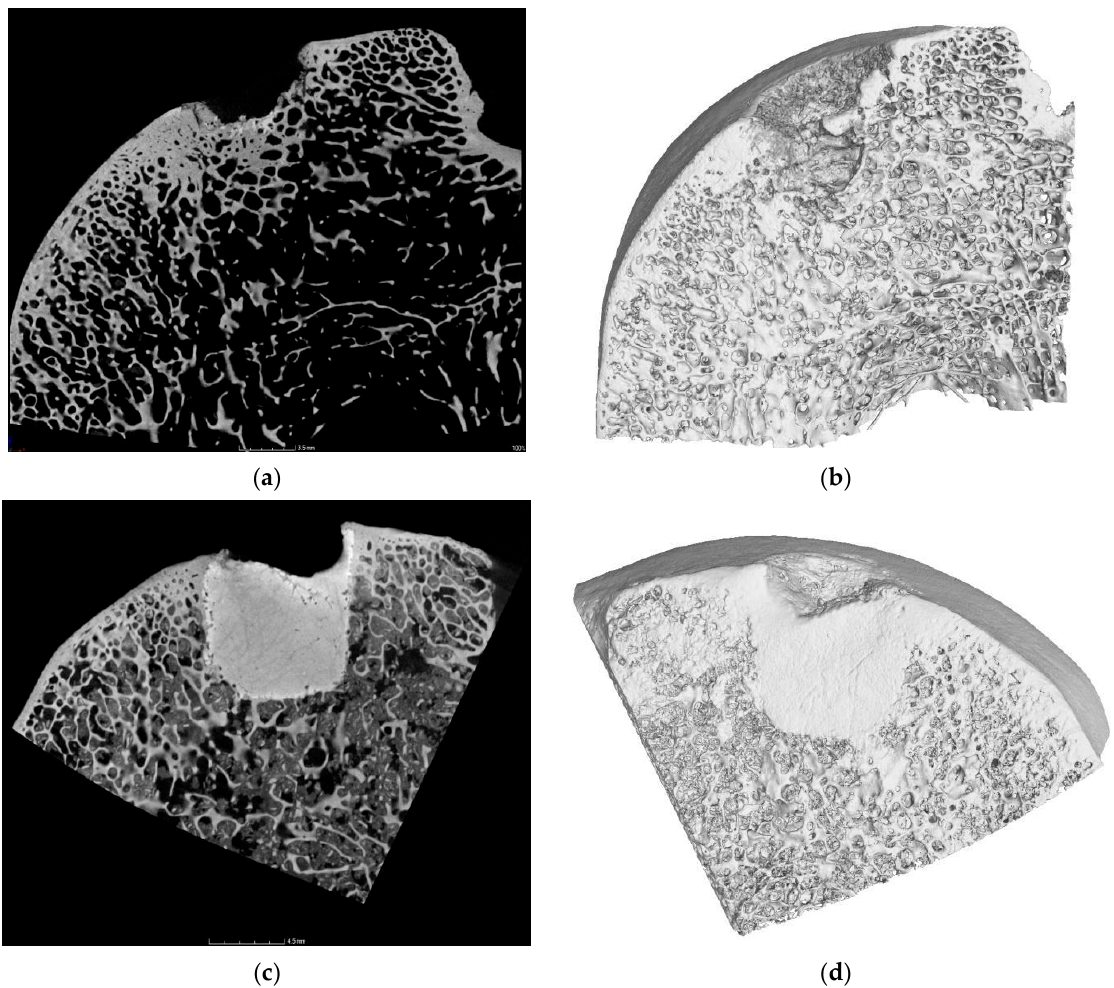
Figure 8. Micro-CT mapping of trochlea femoris showed ( a , b ) successful degradation of biomaterial and trabecular bone remodeling and regeneration. ( c , d ). Although insufficient biodegradability was observed in two cases. Completion of integration with the surrounding bone and there was no observation of pathological changes. Before the micro-CT, the samples of cartilage and subchondral plate were taken for histological evaluation. Sagittal sections, ( a , b ) scale bar = 3.5 mm; ( c , d ) 4.5 mm.